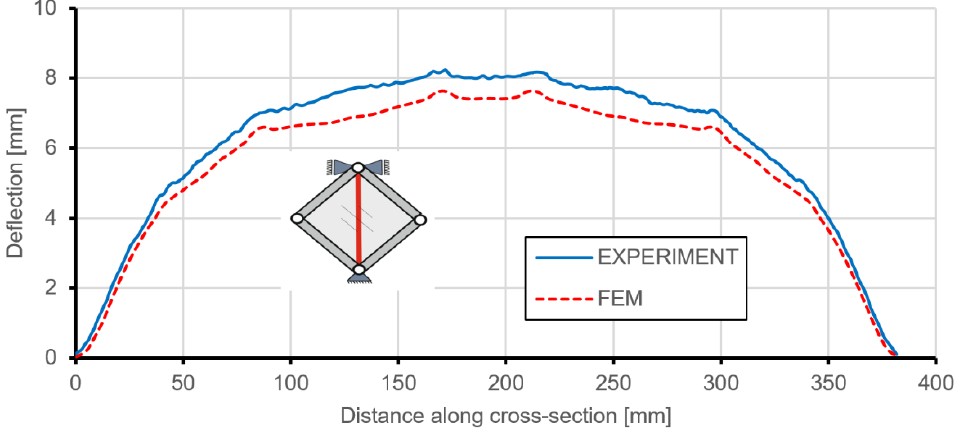
Figure 14. Deflection of a cross-section through the vertical diagonal at the level of maximum load.